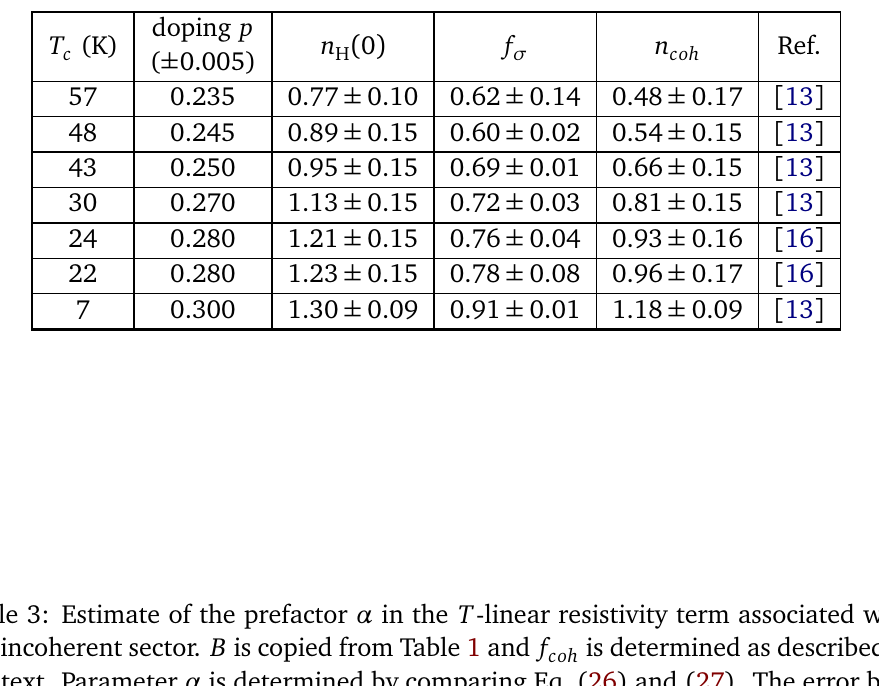
is determined as described in coh and the error bars for α were coh and the coh samples arise due to the c coh